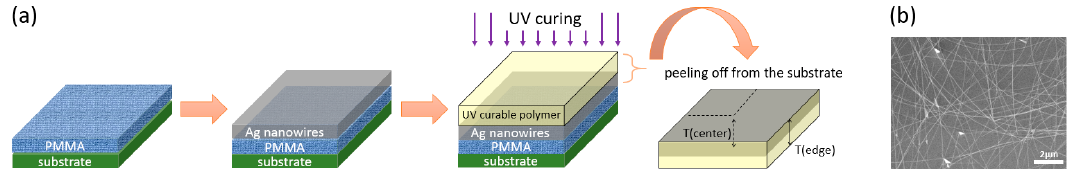
Figure 1. ( a ) Schematic illustration of the fabrication of silver-nanowire-embedded flexible transparent electrodes, displaying the thickness measurement locations. ( b ) A representative SEM image of silver-nanowire-embedded transparent